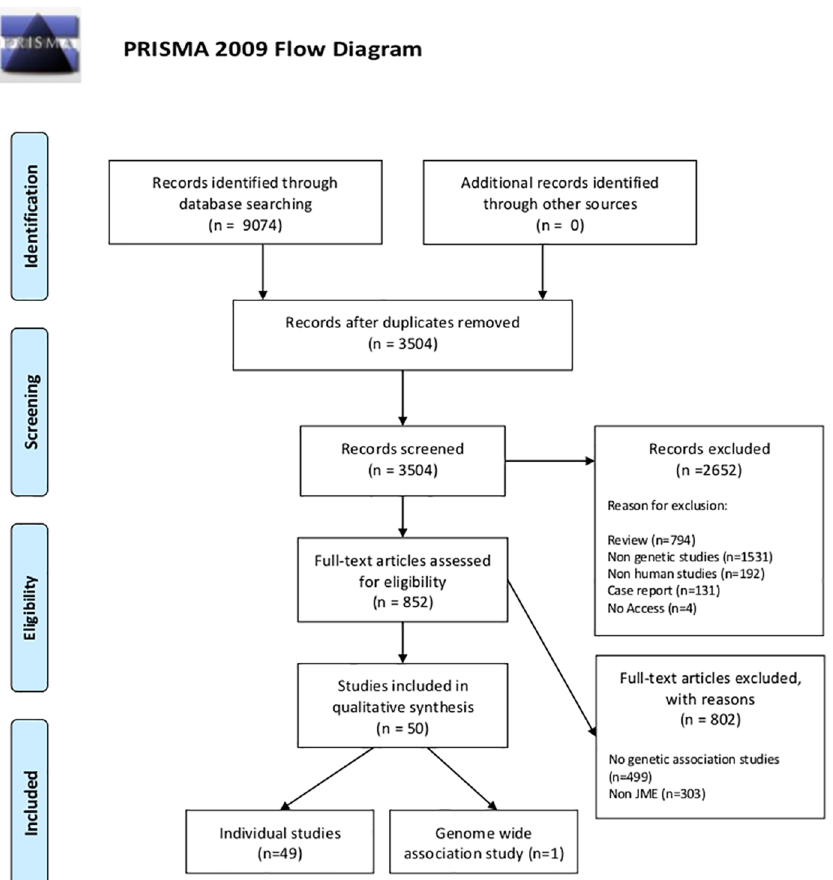
Fig 1. Flow diagram of study identification. From : MoherD, Libeiati A, TetzlaffJ, Allman DG, The PRISMA Group {2009). Preferred Reporting /terns for Systematic Reviewsand Meta- Analyses :The PRISMA Statement. PLoS Med 6(7): e1000097.doi:10.1371/journal.pmed1000097. For more information, visit